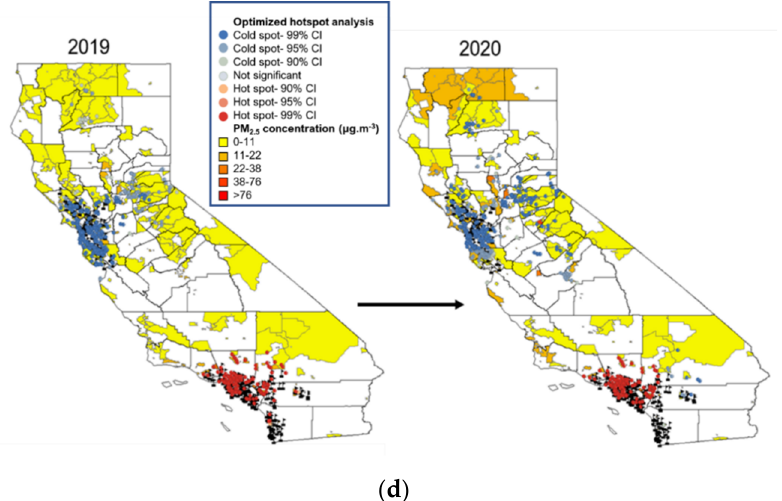
Figure 2. Spatial distribution of PurpleAir measured daily average PM 2.5 concentrations across ( a ) the entire state, ( b ) Los Angeles County, and ( c ) San Francisco, Bay area scheme during the 4th and 5th July period in 2019 and 2020. Panel ( d ) shows the spatial hotspot analysis across the state for average PM 2.5 concentration during the 4th and 5th July period in 2019 and 2020.